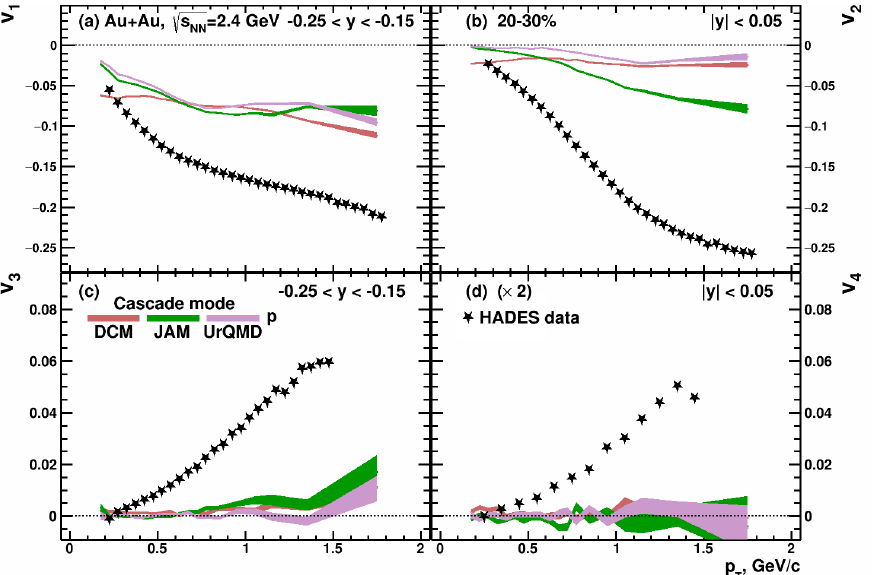
Figure 4. p T dependence of anisotropic flow coefficients v 1 , v 2 , v 3 and v 4 of protons ( a – d ) in the √ s NN = 2.4 GeV. The black-closed symbols denote the published 20–30% central Au + Au collisions at data from the HADES experiment [17]. The red, green and purple bands represent the results from the cascade mode of DCM-QGSM-SMM, JAM, and UrQMD models, respectively. The uncertainties of the simulated model data are